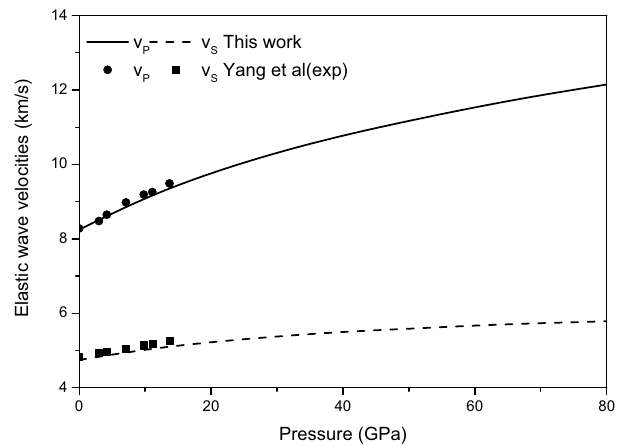
Figure 10. Elastic wave velocities of magnesite from 0 to 80 GPa.